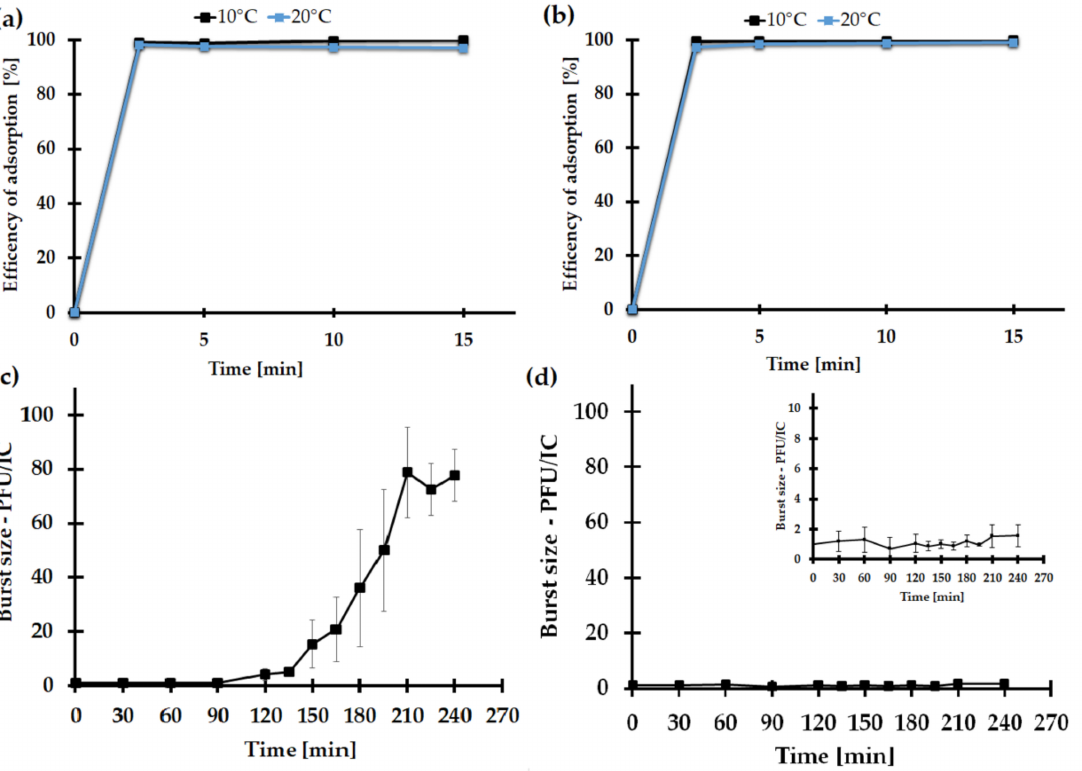
Figure 6. Phage KASIA development. ( a ) The adsorption of the phage particles to the bacterial cells was assessed after 1, 2.5, 5, 10, and 15 min in R2A medium and ( b ) LB medium. ( c ) One-step growth curve in R2A medium and ( d ) in LB medium, conducted for 240 min and assessed in 15–30-min time intervals. The graph for the LB medium is presented in two versions: on the same scale as R2A (to illustrate the difference in the number of phage particles produced) and on a scale 10 times smaller (for the better visualization of the results obtained on the LB medium). Each experiment was conducted five times, and the average values are plotted with standard deviation